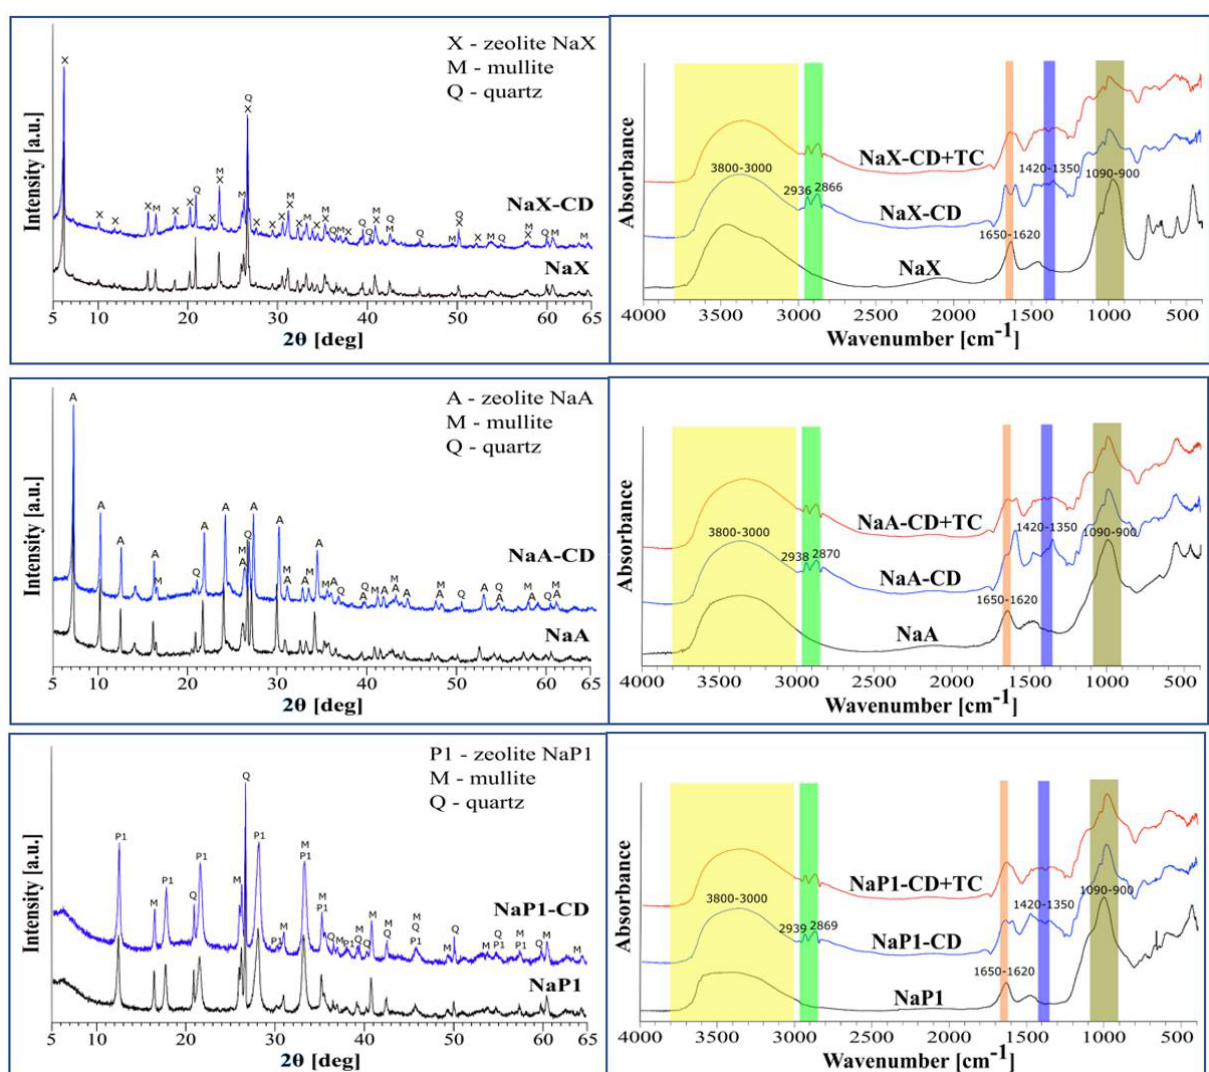
Figure 2. XRD patterns of NaX, NaA and NaP1 ( left column ) before and after modification with β - CD, and FTIR spectra of the studied organo-zeolites before and after TC adsorption ( right column ). The lower contribution of the amorphous phase is attributed to the NaX, suggesting the highest degree of crystallinity. The peaks characteristic for the zeolite phases can be recognized by the strongest reflections at the following d hkl values: 14.45; 8.85; 3.34;